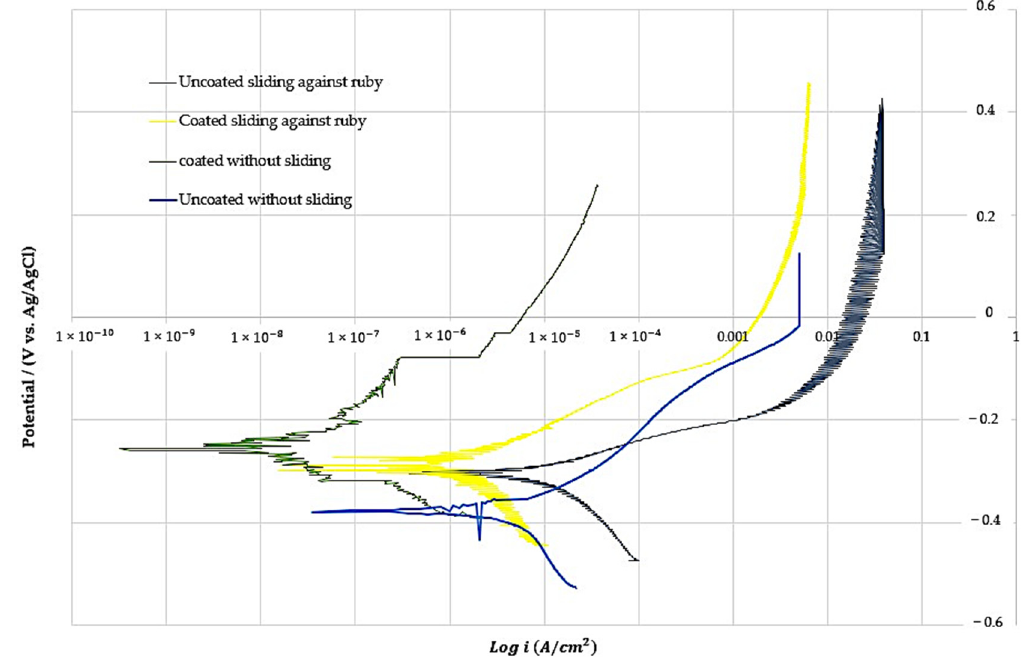
Figure 11. Potentiodynamic polarization plots obtained for uncoated and coated samples with and without sliding against ruby balls.